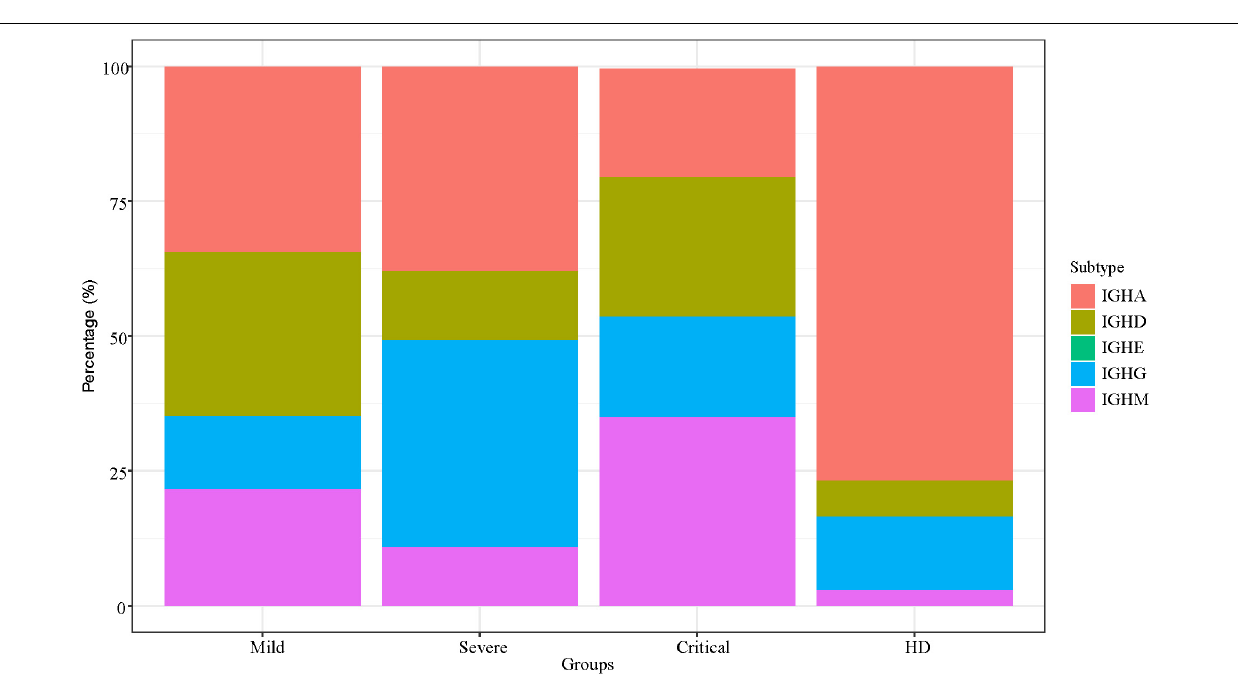
FIGURE 4 | IGH isotype characteristics. IGH isotype characteristics of SARS-CoV-2 infection across patients. The Y -axis shows the percentage of each subtype of